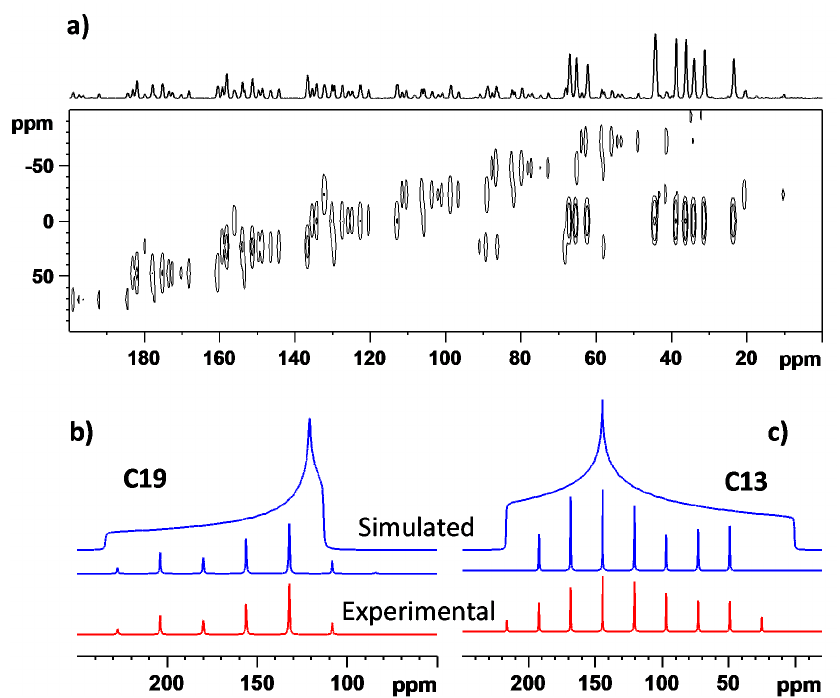
Figure 6. The 2D 13 C CP/PASS NMR spectrum of polymorph MI (panel a ), and selected manifolds, shown in red: C19 (C=O) and C13 (CH=) sites in panels ( b , c ), respectively (the corresponding simulated spinning sidebands are shown in blue).